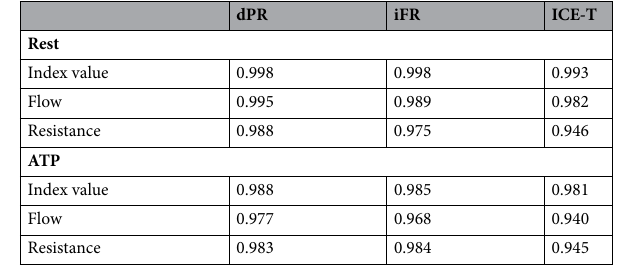
Table 3. The internal reliability of index values, flow velocity, and resistance concerning the dPR, the iFR, and the ICE-T. ATP adenosine triphosphate, DPR diastolic pressure ratio, ICE-T intracoronary electrocardiogram- triggered resting index, iFR instantaneous flow